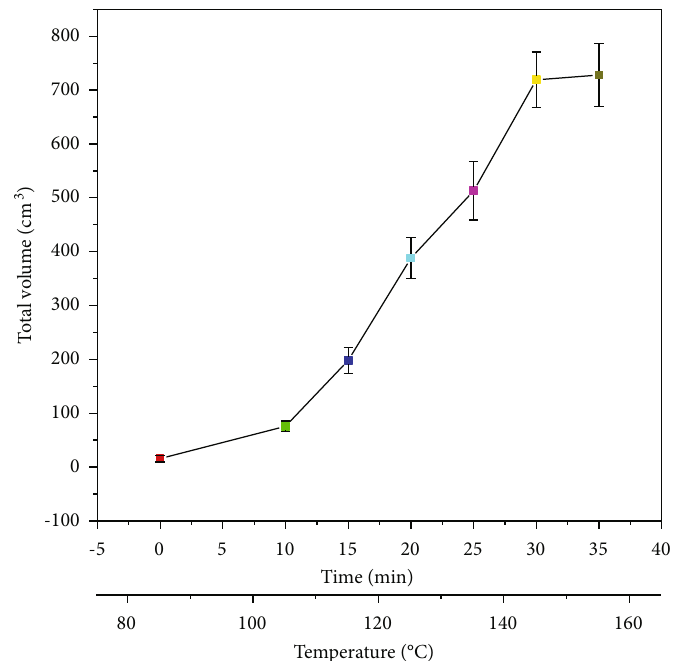
Figure 2: Volume expansion during foaming at various times (and temperature).